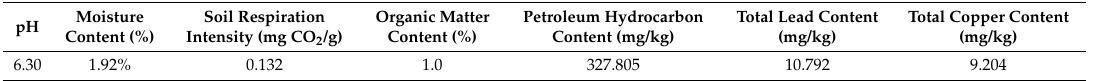
Table 1. Characteristics of the studied